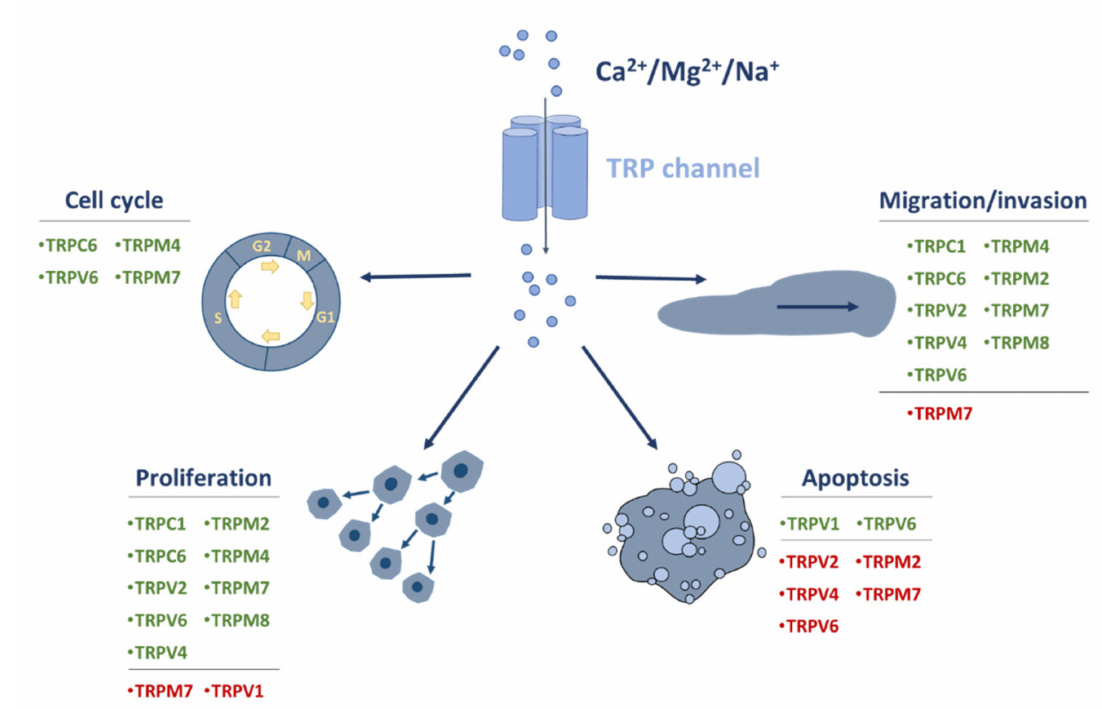
Figure 2. Overview of the role of TRP channels in cell functions of cancers of the gastrointestinal tract. TRP channels, which are permeable to monovalent and divalent cations, such as Na + , Ca 2 + and Mg 2 + , are often dysregulated in cancer cells. These can lead to enhancement / suppression of proliferation, migration and invasion, cell cycle progression, and apoptosis. Channels with activity promoting a particular function are marked in green. Channels with activity suppressing a particular function are marked in